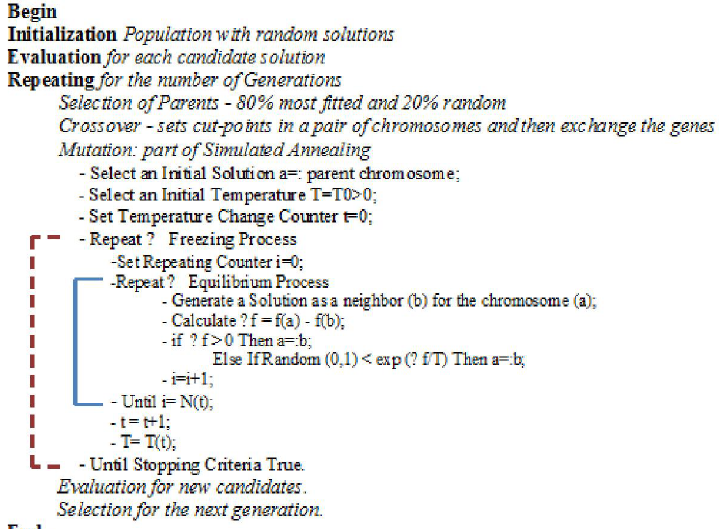
Fig. 3. Mutation operator as a part of SA algorithm adopted from (Coello et al.,